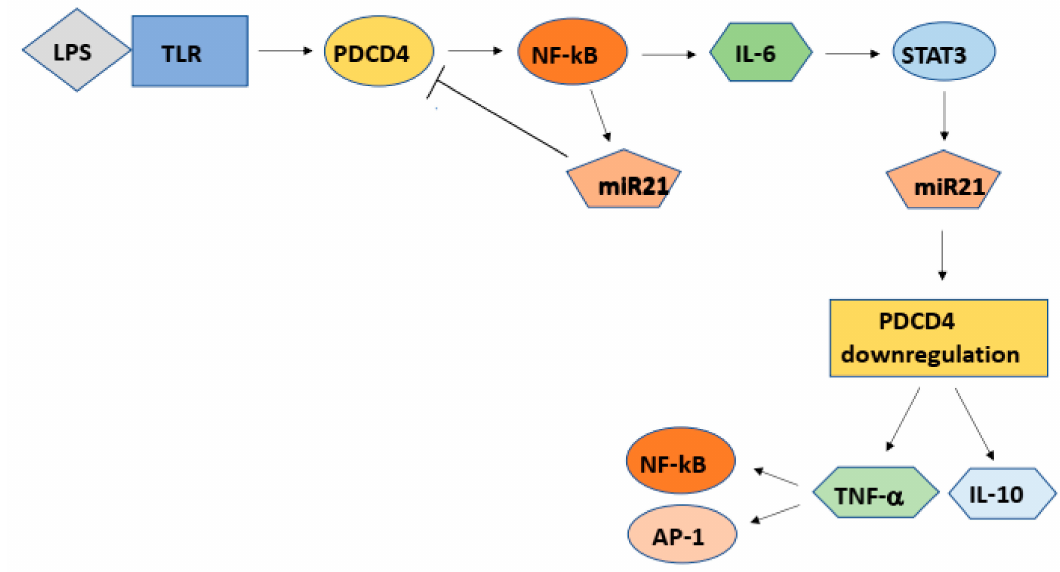
Figure 8. PDCD4 expression is suppressed by miR21 via NF- κ B and / or STAT3 in the cells in the inflammatory